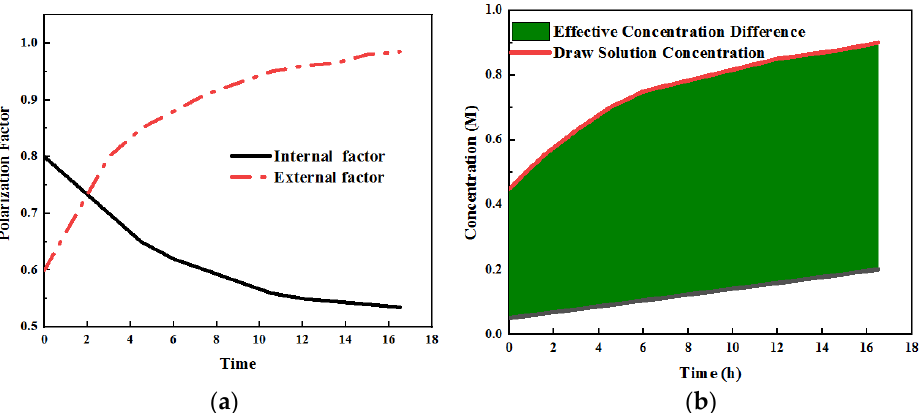
Figure 8. ( a ) The polarization factors of internal and external concentration differences calculated by the model, as well as ( b ) the salt concentration and effective concentration difference on both sides of the active layer of FO membrane during membrane fouling (M).